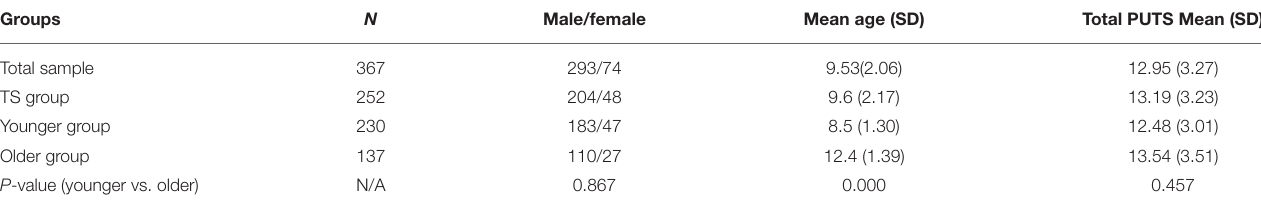
TABLE 1 | The clinical characteristics for different groups. Groups